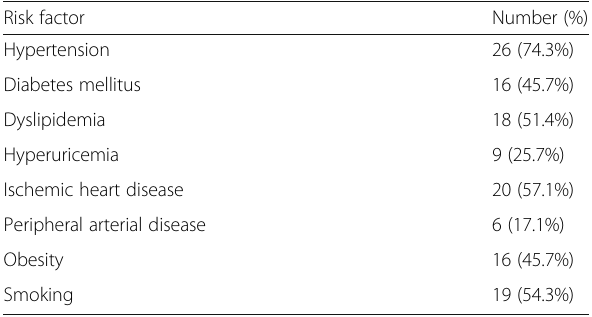
Table 1 Risk factors of patients presenting with significant symptomatic carotid stenosis